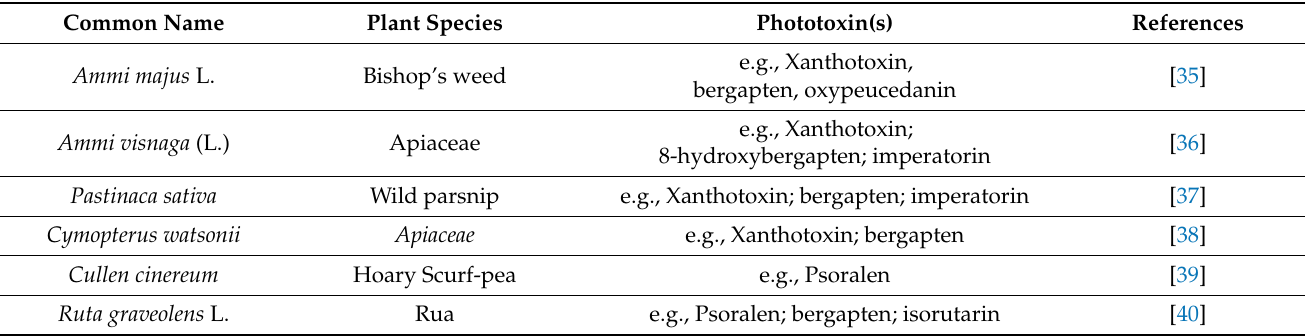
Table 1. Examples of photototoxic plant species and their reported some